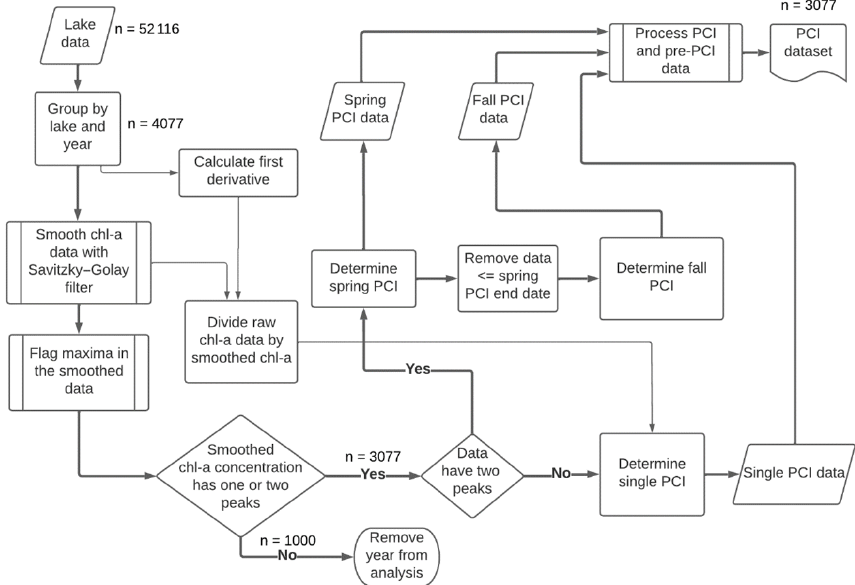
Figure 2. Workflow for detecting PCIs and processing data. For each lake sampling point, chlorophyll- a (Chl- a ) data are smoothed with a Savitzky–Golay filter, and then PCIs are detected based on peaks in the chlorophyll- a concentration. PCIs are flagged as spring, fall, or single PCIs. The data density is shown at key points along the